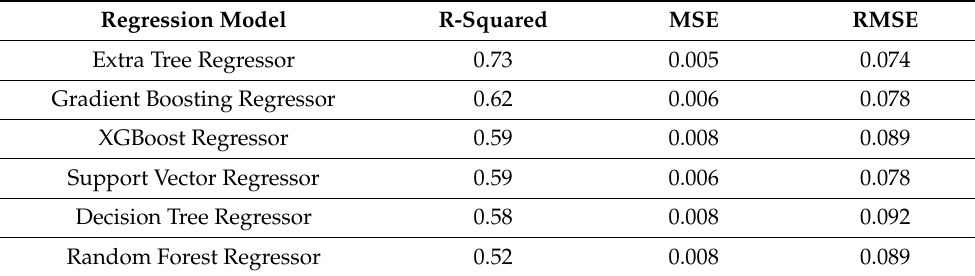
Table 3. Performance Comparison of Various Regression